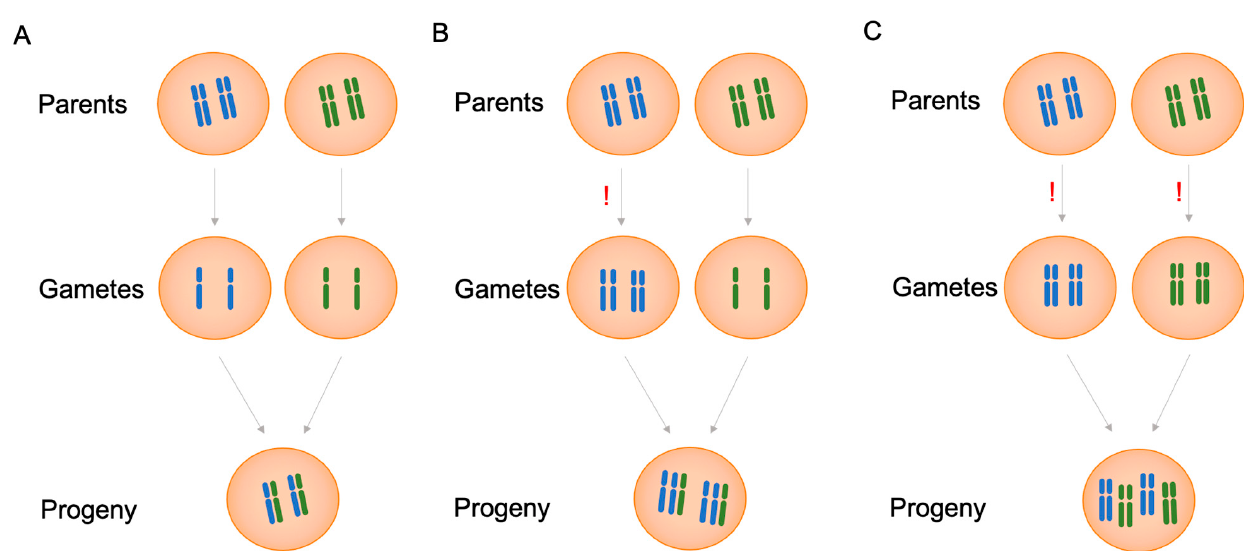
Figure 1. Possible types of gametes after meiosis and offspring formation in autopolyploids. ( A ) Normal meiosis: diploid progeny (fertile). ( B ) Abnormal meiosis autotriploid progeny (sterile) and ( C ) Abnormal meiosis autotetraploid progeny (fertile). Symbol !: nondisjunction in meiosis.